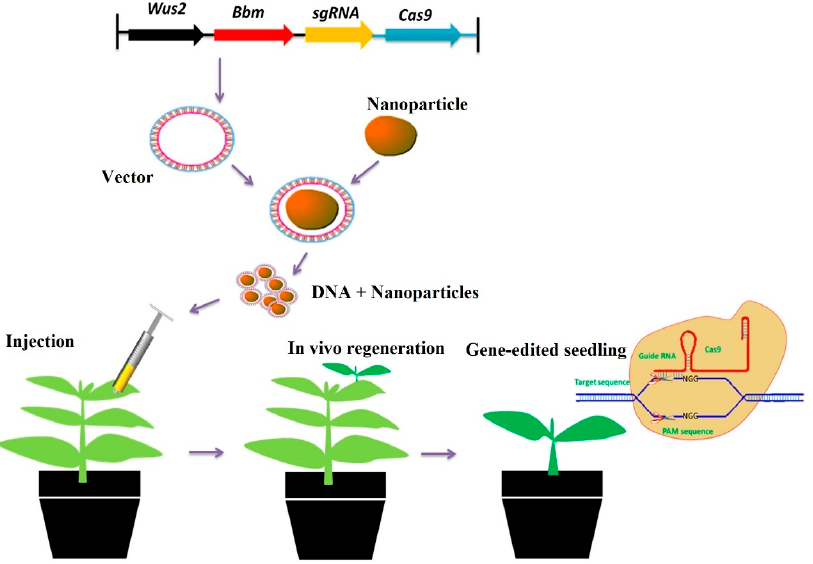
Figure 12. Illustration of prospective applications of nanoparticle-based delivery of CRISPR/Cas9 in plant engineering. Reproduced with permission from [191], 2020, John Wiley and Sons.